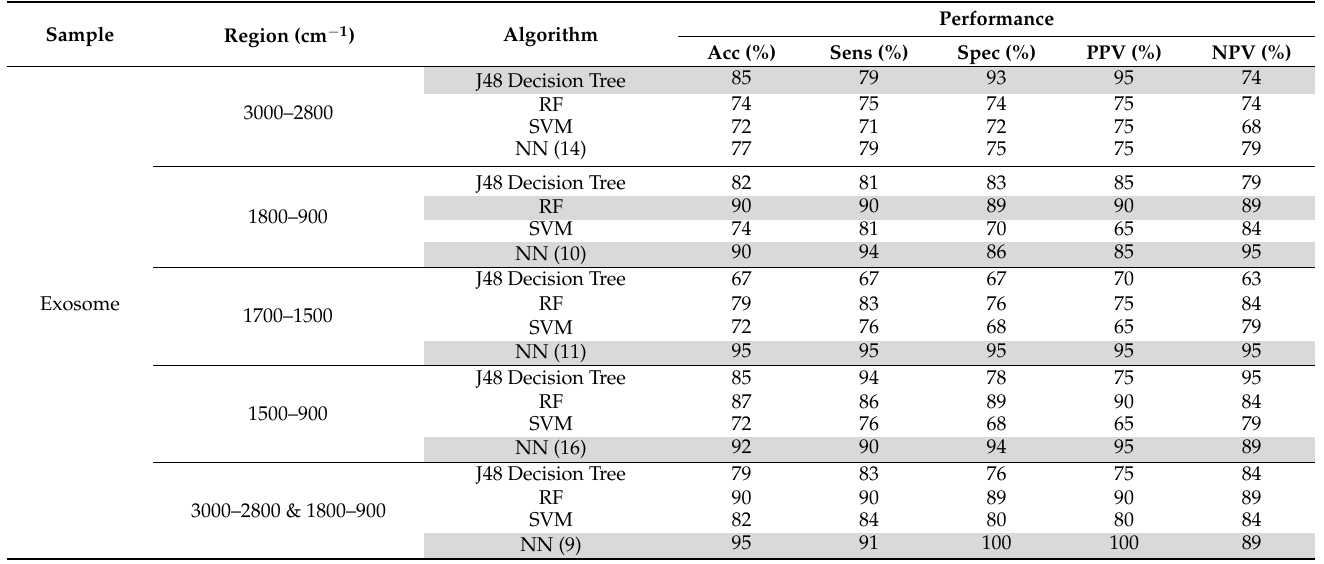
Table 3. Comparison of multiple advanced machine learning algorithms for classification models in exosome samples.